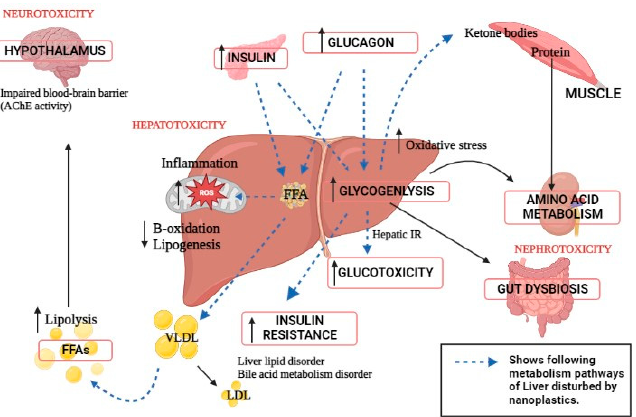
Figure 2. Disturbed metabolism pathways of the liver and neighboring organ dysfunction due to nanoplastics exposure.